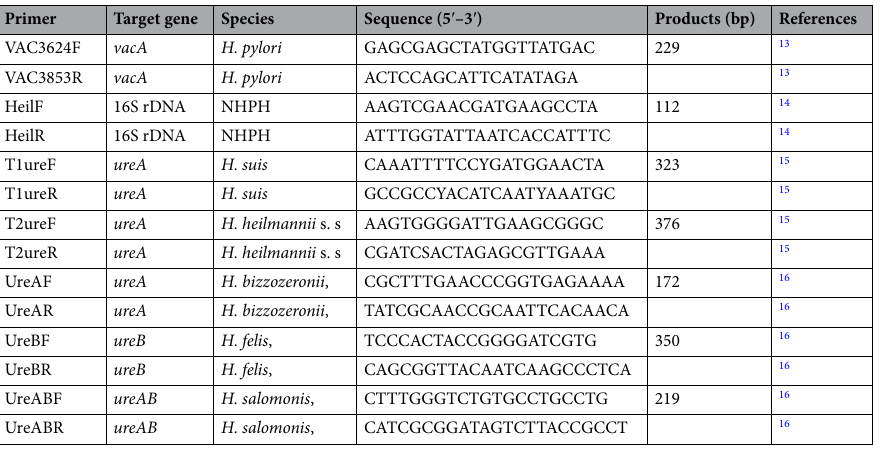
Table 1. Primers for